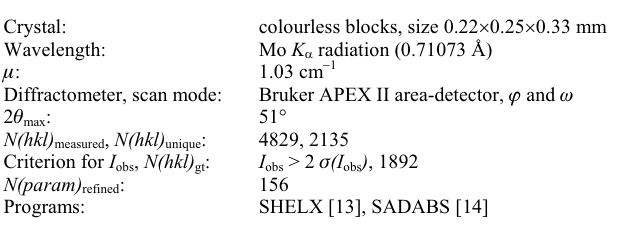
Table 1. Data collection and